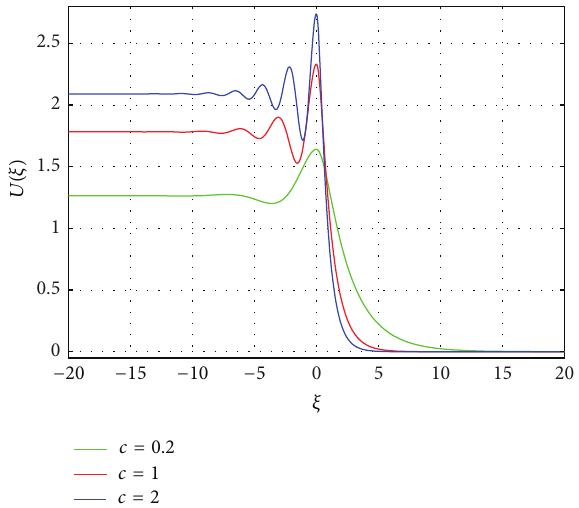
Figure 21: Plot of the approximate damped oscillatory solution (33) for different value of 𝑐 with 𝑎 = −0.2 , 𝑏 = 0.6 , 𝑝 = 2 , 𝛽 = 1 , and 𝑟 = −1 .